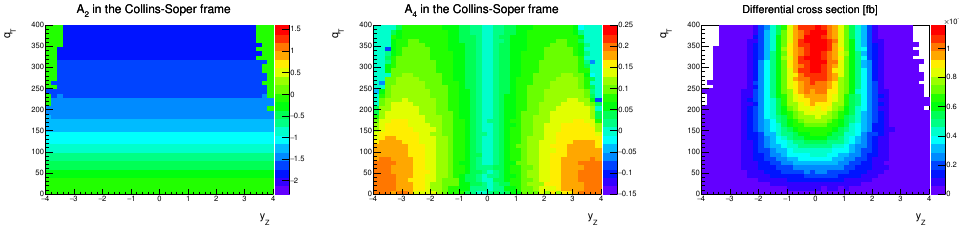
Figure 7 . Angular coe(cid:14)cients A 0 mark scenario S0 c . Comparing with other (cid:12)gures, we extended the range of the A 2 for a better demonstration.